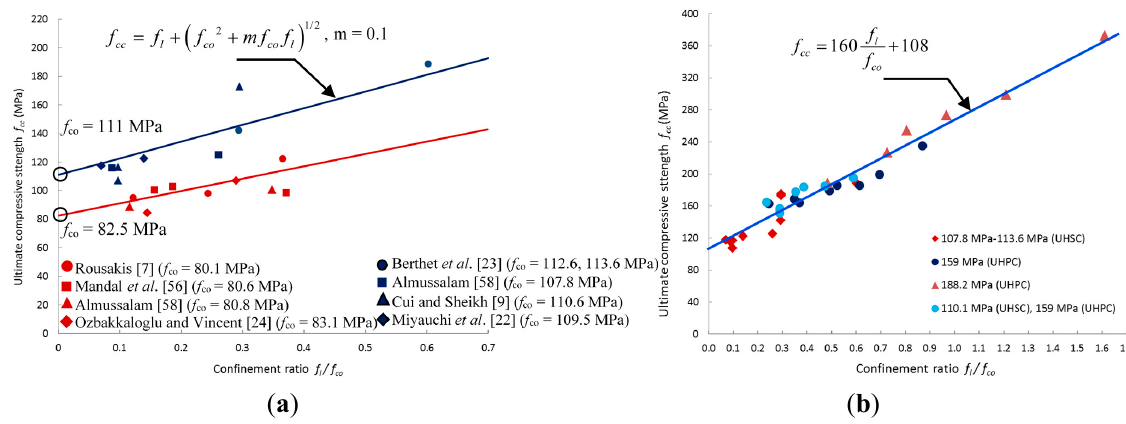
Figure 2. ( a ) Verification of modified Hoek–Brown criterion for high and ultra-high compressive strength levels; ( b ) Proposed empirical model from f co = 108 to 190 MPa for UHSC and UHPC data of CFRP, GFRP, AFRP jackets.